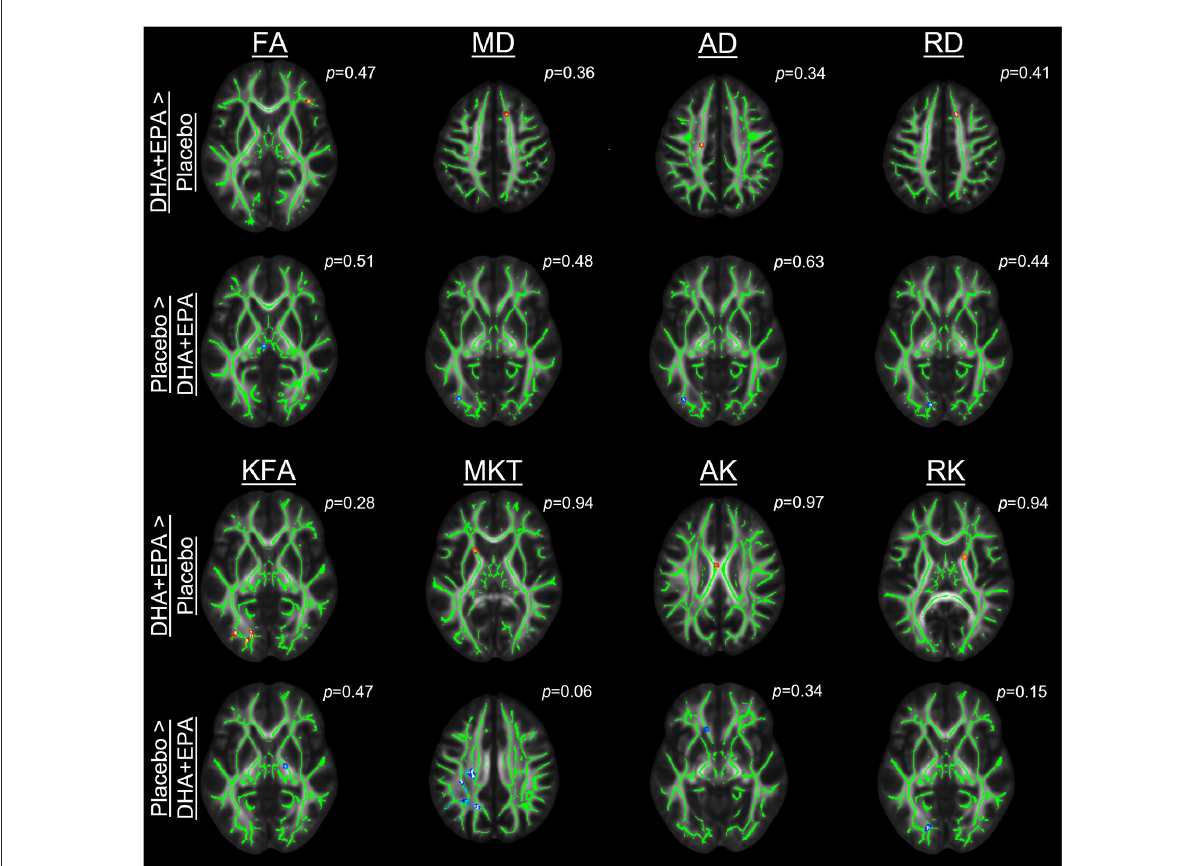
FIGURE2 Group-wise differences in diffusion tensor and kurtosis metrics following treatment. Changes in diffusion tensor and kurtosis metrics were evaluated between groups using tract-based spatial statistics. No statistically significant clusters were observed for diffusion tensor metrics (FA, MD, AD, RD). For diffusion kurtosis metrics, a cluster of voxels ( n = 1,704) was identified where the placebo groups demonstrated a greater increase in the mean of the kurtosis tensor (MKT) than the DHA + EPA group. Other diffusion kurtosis metrics (KFA, AK, RK) revealed no differences. For each analysis, results are overlaid on the template brain with the skeletonized white matter voxels in green. Statistical images are presented for the smallest observed family-wise error corrected p -value for each contrast (DHA + EPA > Placebo: top contrast, red-yellow voxels; Placebo > DHA: bottom contrast, blue-light blue